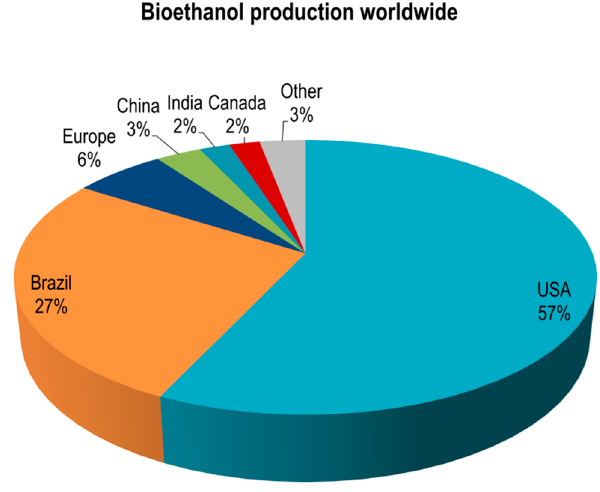
Figure 1. Worldwide bioethanol production.